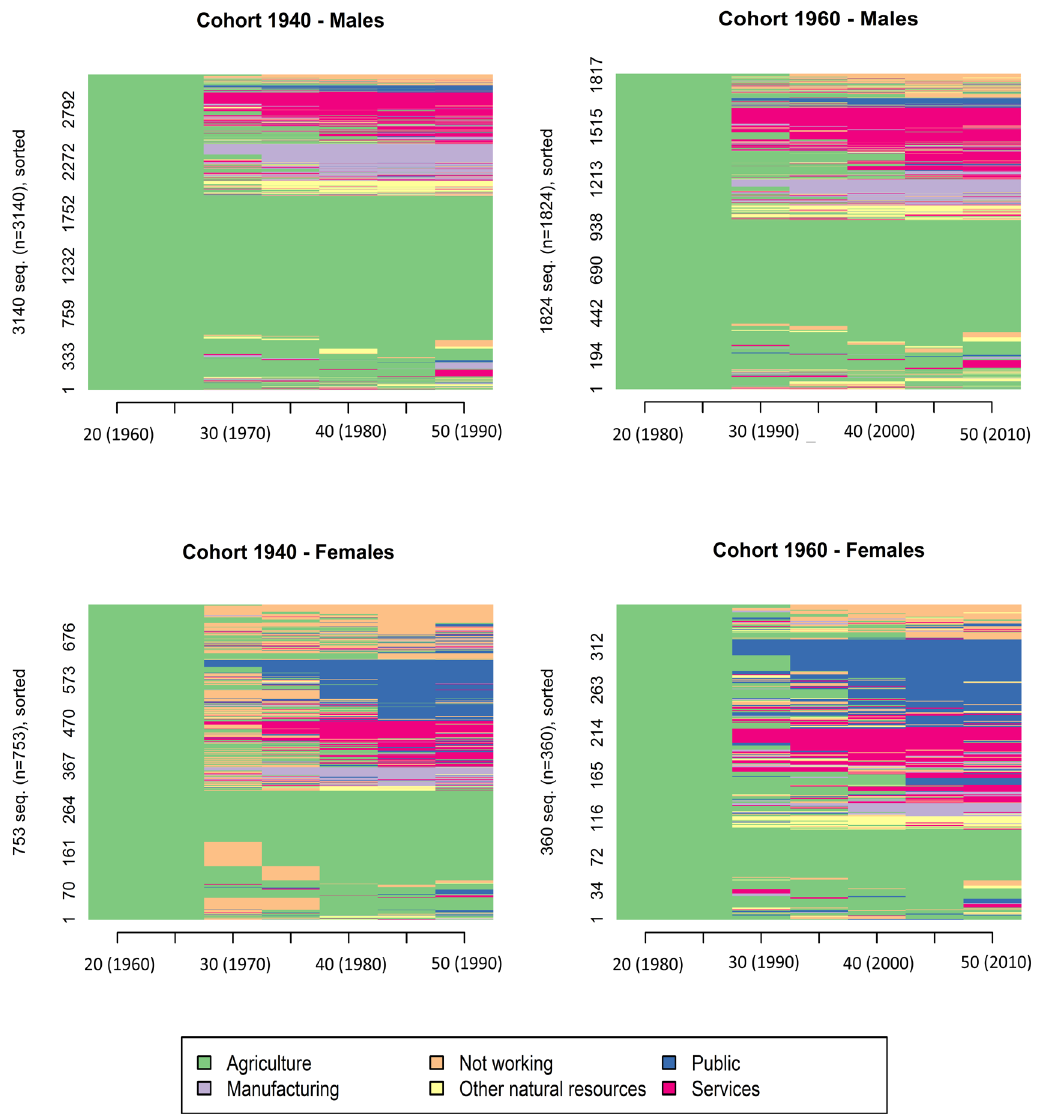
Fig. 1. Sequence index plot of the employment trajectories divided by cohort and